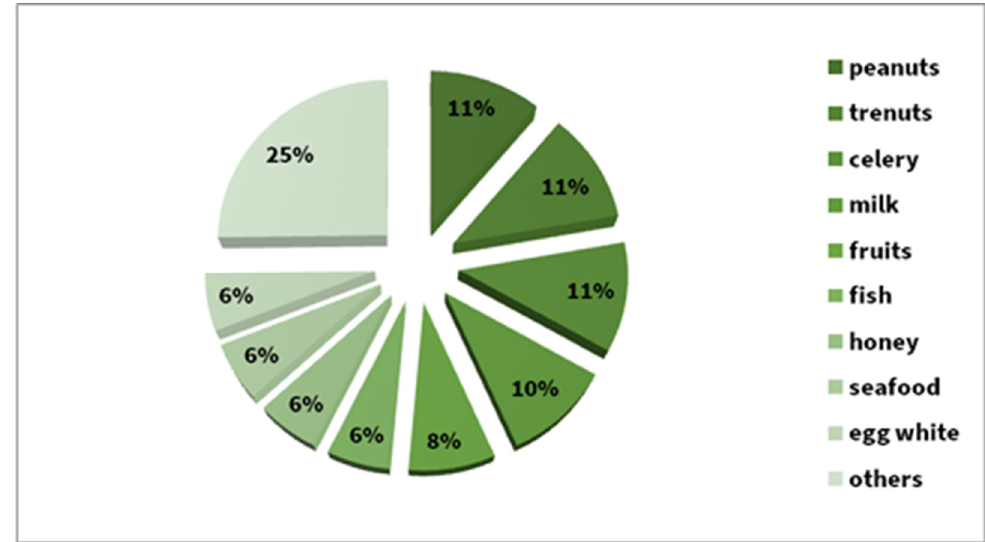
Figure 10. Food causes of anaphylaxis in the whole study group (%).